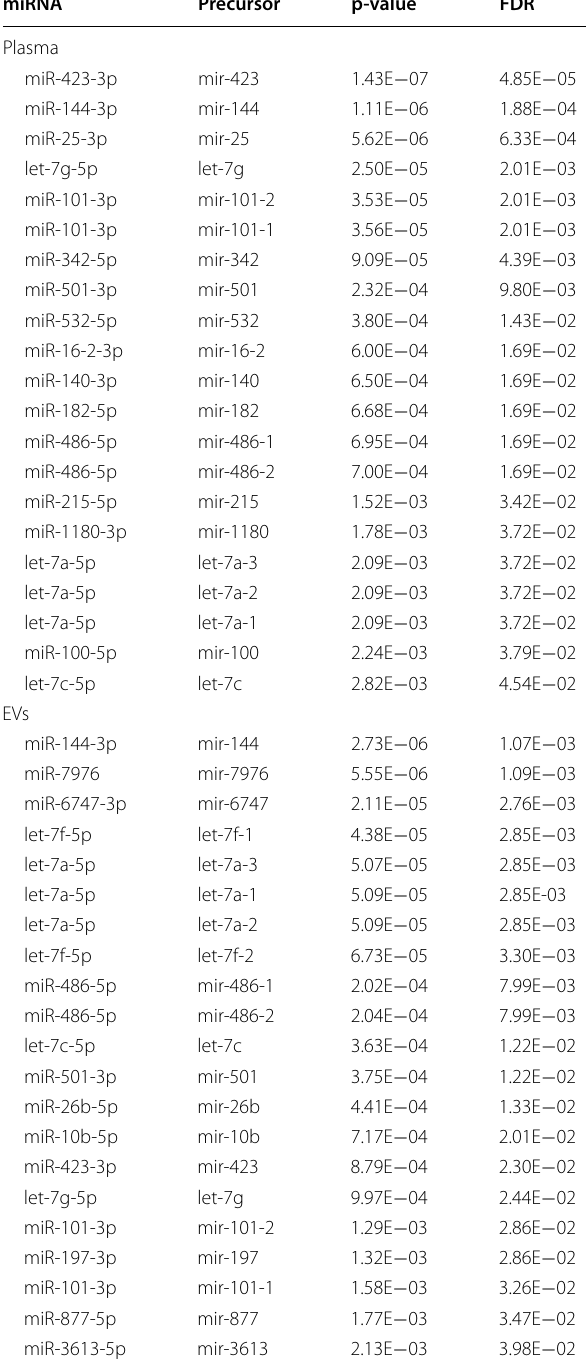
Table 4 Results of the Levene’s test for equality of variances in plasma and EVs between ALL survivors and